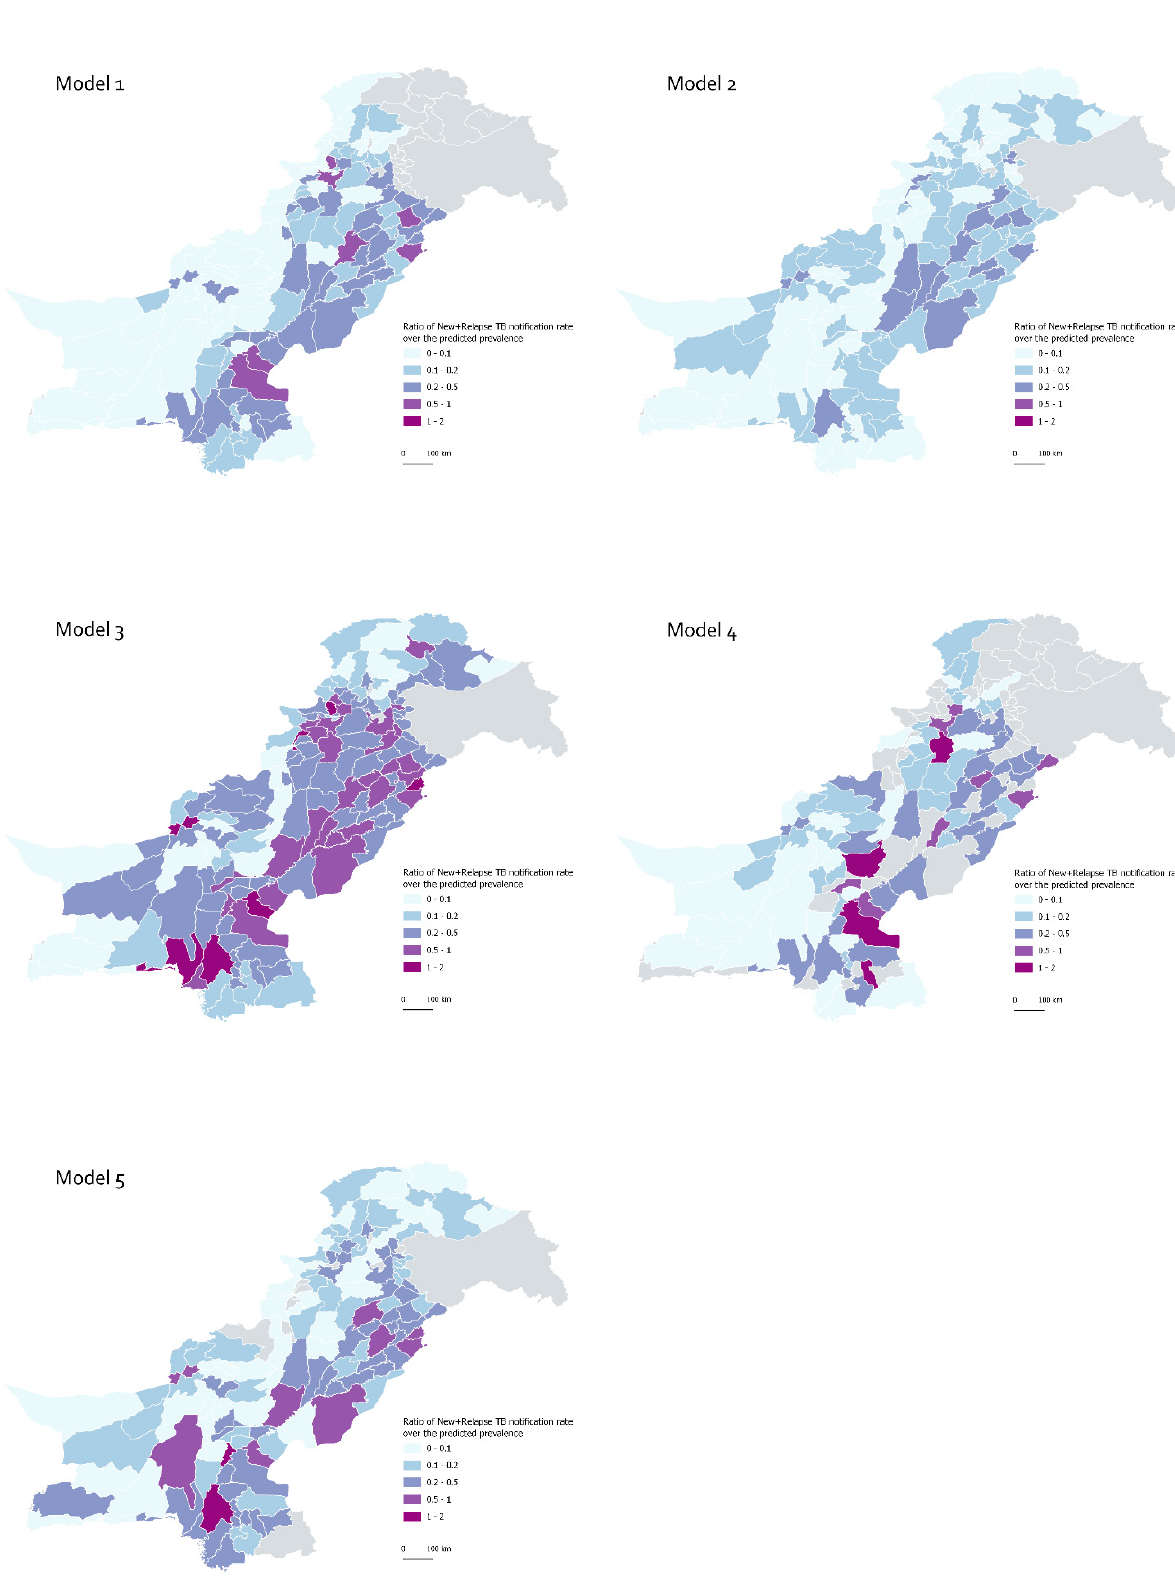
Figure 2. Predicted district-level TB prevalence in 2018, by model.